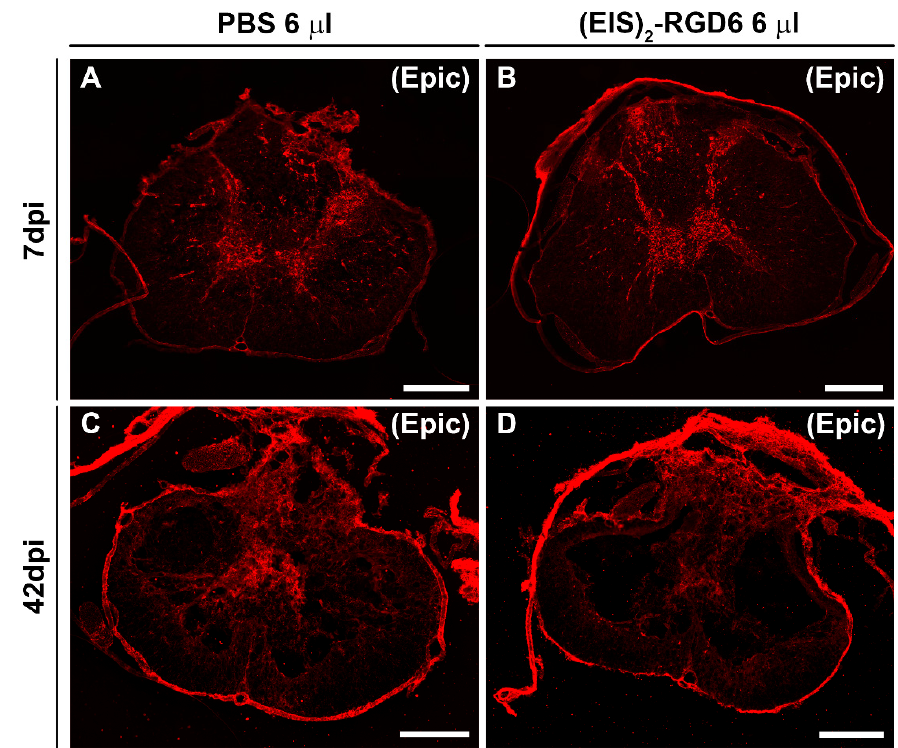
Figure 20. Representative images from fibronectin (FN) immunostained sections. Representative images from FN immunostained spinal cord sections corresponding to the lesion epicentre, used to carry out the densitometric analysis of fibrosis in experiment (EIS) 2 -RGD6 III at 7 and 42 days post-injury (dpi): ( A ) PBS 6 µL group at 7 dpi; ( B ) (EIS) 2 -RGD6 6 µL group at 7 dpi; ( C ) PBS 6 µL group at 42 dpi; and ( D ) (EIS) 2 -RGD6 6 µL group at 42 dpi. Scale bars, 500 µm. Please note that data obtained from the densitometric analysis of fibrosis in these sections can be found in Figure 16G,H.